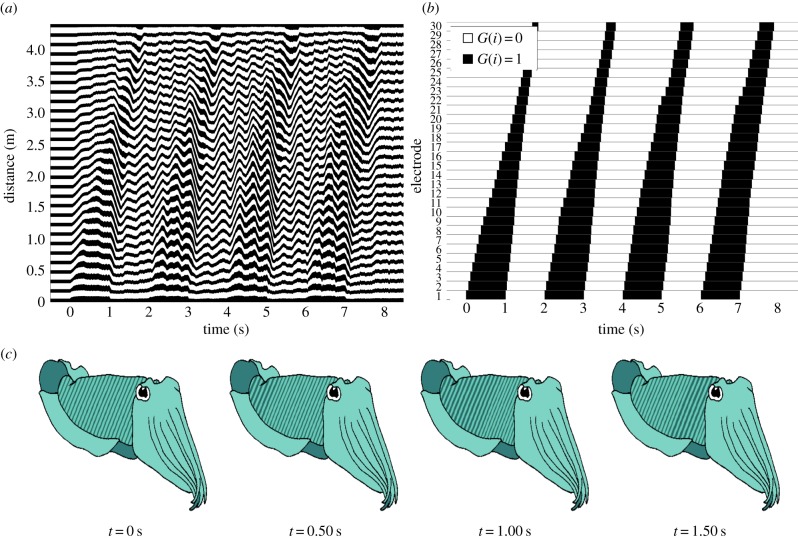
Full propagation of actuation along the thread using parameters ron = 3.7, and roff = 2.6. Cell 1 (manual cell) activates and deactivates in cycles of 1 s from t = 0 for 8 s. (a) View of material and (b) global state transition diagram; (c) the actuation propagation, visualized on an illustration of a cuttlefish body. See the electronic supplementary material for an animation of the simulation. (Online version in colour.)